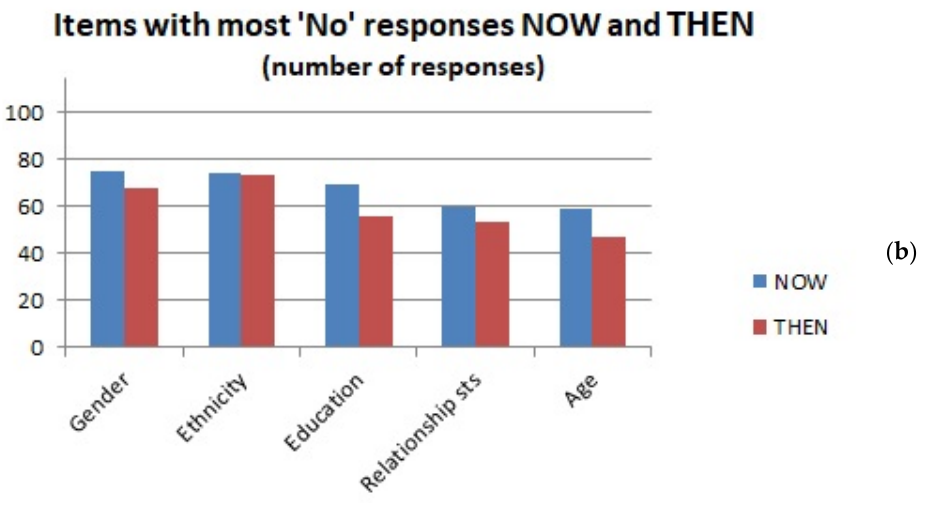
Figure 2. Salient findings for the “Yes” and “No” responses in Table 3. ( a ): Items with most “Yes” responses; ( b ): Items with most “No” responses.